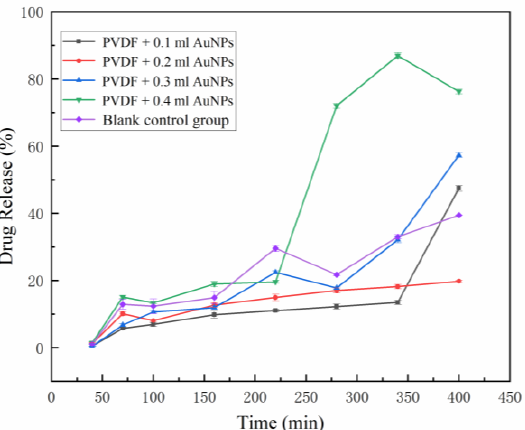
Figure 7. Cumulative release rate curve of drug-loaded fiber membrane in different groups: PVDF + 0.1 mL AuNPs, PVDF + 0.2 mL AuNPs, PVDF + 0.3 mL AuNPs, PVDF + 0.4 mL AuNPs, blank control group. The concentration of the AuNPs was 0.60 nM.